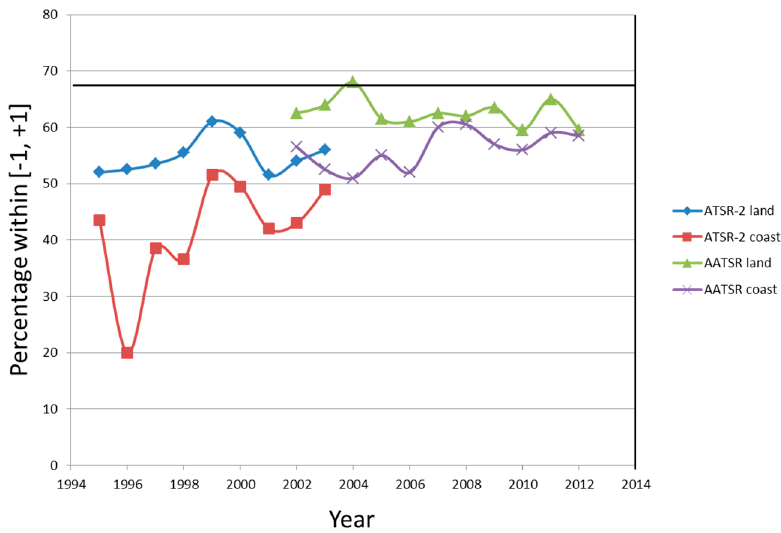
Figure 9. Percentage of Δ within [ − 1,+1] per year for version 4.21 of the SU algorithm for ATSR-2and AATSR over land and coastal sites. The black line shows the optimum percentage value.